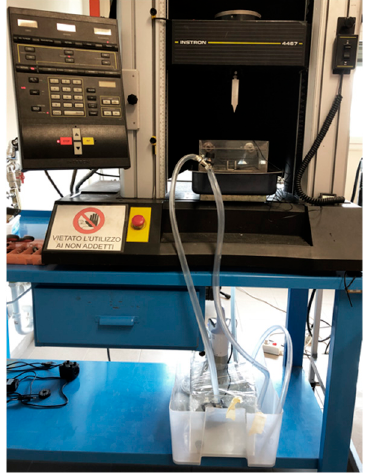
Figure 1. Complete system to perform the